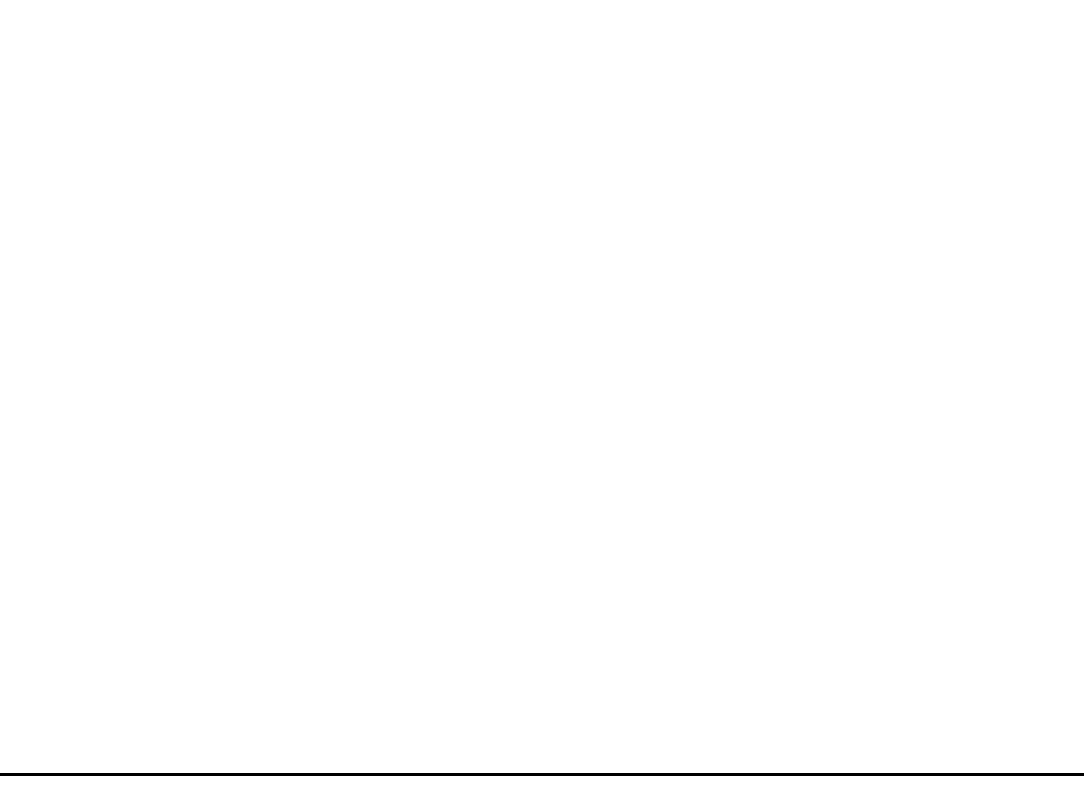
PO ) n- subnetwork along c 2 4